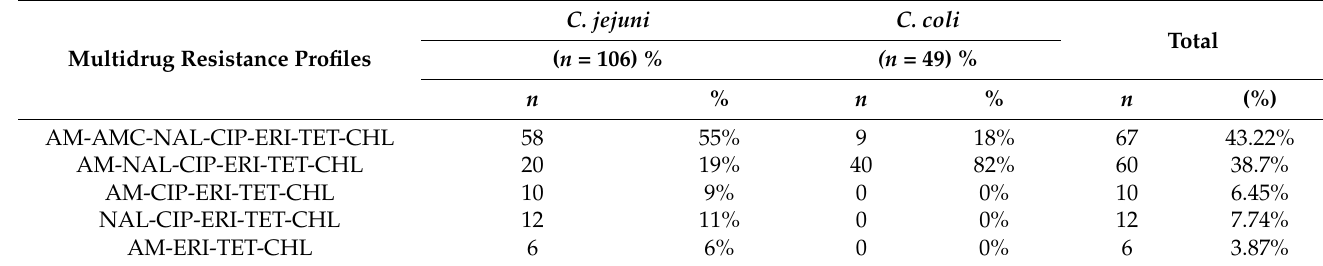
Table 3. Multidrug resistance profiles of Campylobacter jejuni and Campylobacter coli .